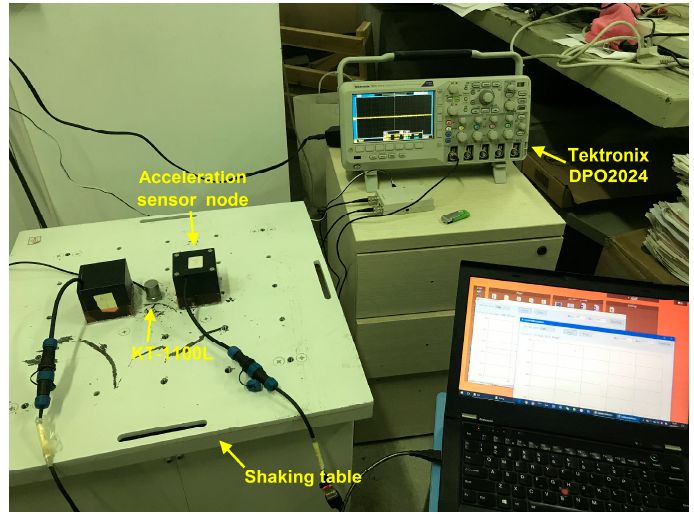
Figure 7. The comparison test.